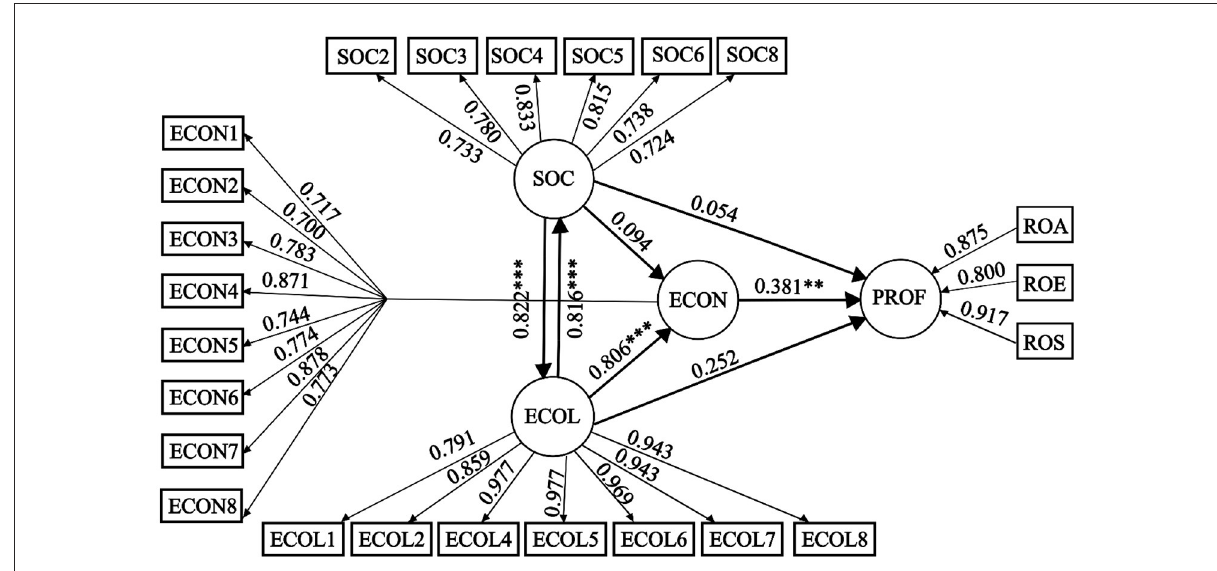
FIGURE2 The final path model and coefficient estimates. **: p < 0.05.***: p < 0.001. Source : Authors’ compilation.